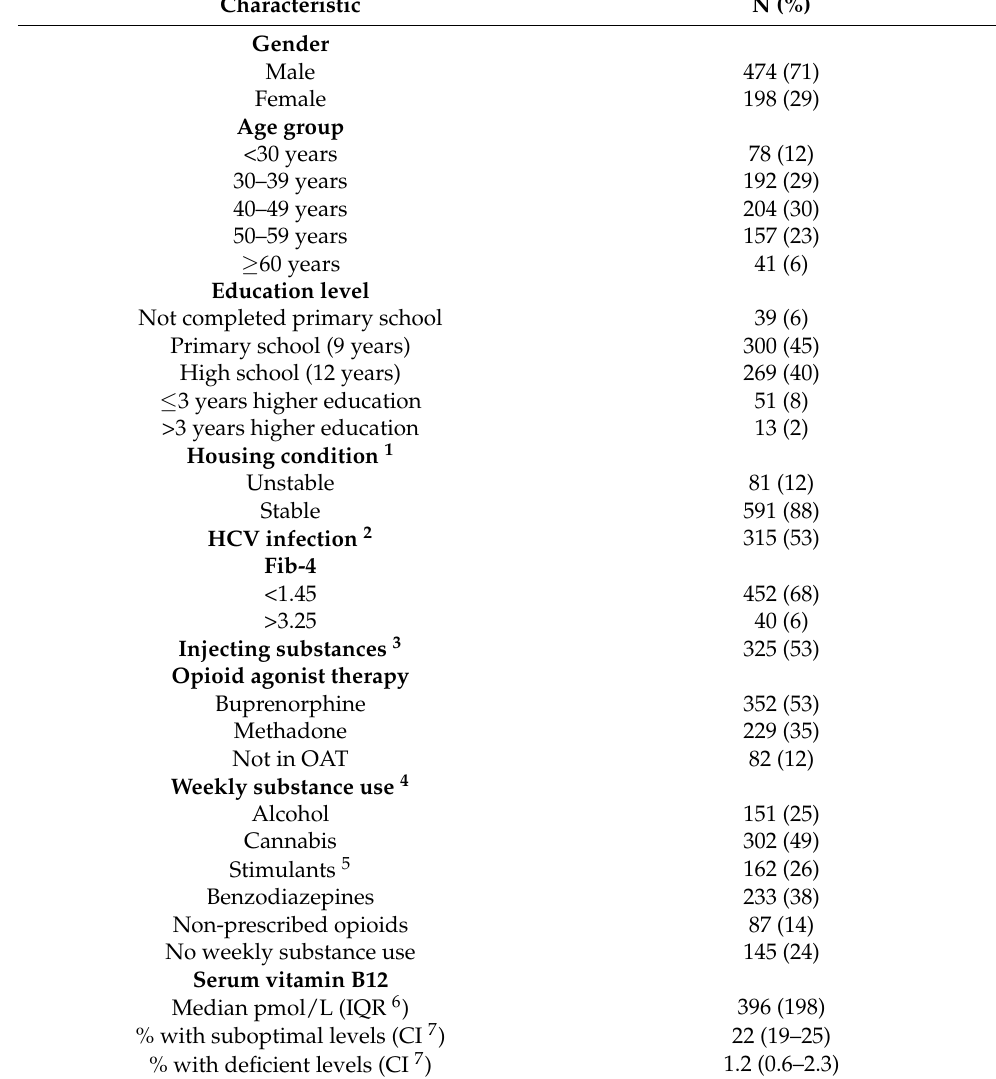
Table 1. Baseline characteristics of the